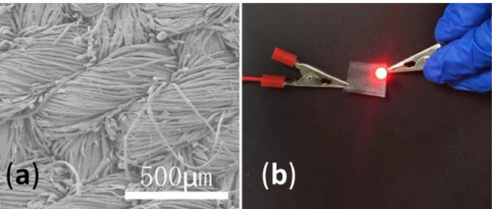
Figure 7. ( a ) SEM micrograph of the SWCNTs/GA-chitosan coated textiles after 1000 cycles of mechanical rubbing using a bristle brush, and ( b ) corresponding electrical conductivity (reprinted with permission from Ref. [6] Copyright 2022